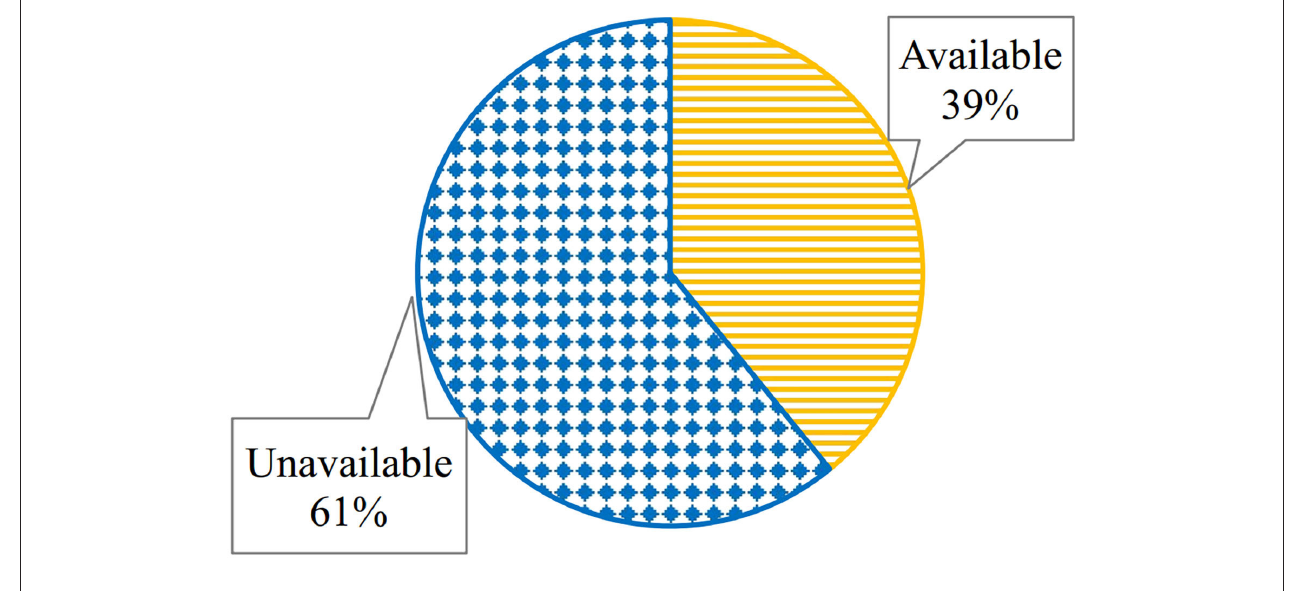
FIGURE 3 | General claimed availability of WEF nexus tools.